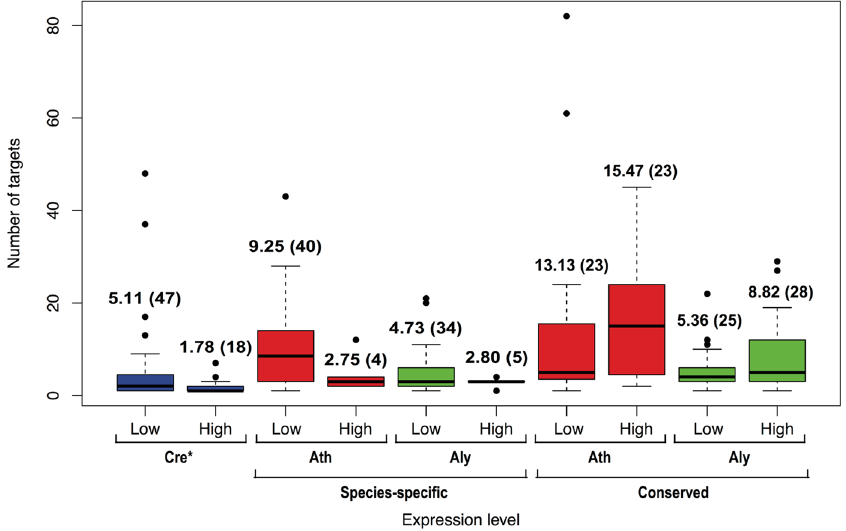
Figure 7. Comparison of the number of predicted cleavage targets for lowly expressed and highly expressed miRNAs. Boxplots show the number of predicted cleavage targets for miRNAs with low expression ( < 500 CPM) and high expression ( ≥ 500 CPM) identified in the AGO3-pulldown libraries from C. reinhardtii (blue) and for species-specific or conserved miRNAs from Arabidopsis thaliana (red) or Arabidopsis lyrata (green). Conserved miRNAs are shared between A. thaliana and A. lyrata and many have experimentally validated roles. MicroRNAs that had no predicted targets were excluded from this plot. The average number of targets (including outliers) and the sample size for each category are shown above the boxes. The target numbers were compared between the two expression-level groups for each species and an asterisk next to the species abbreviation indicates a significant difference ( p < 0.05 by Wilcoxon rank sum